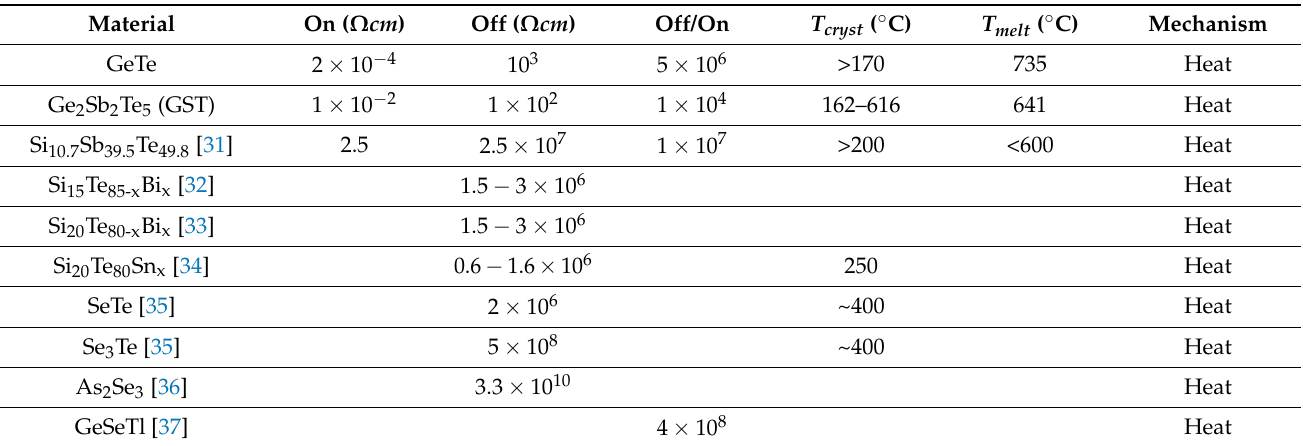
Table 1. List of PCM materials for